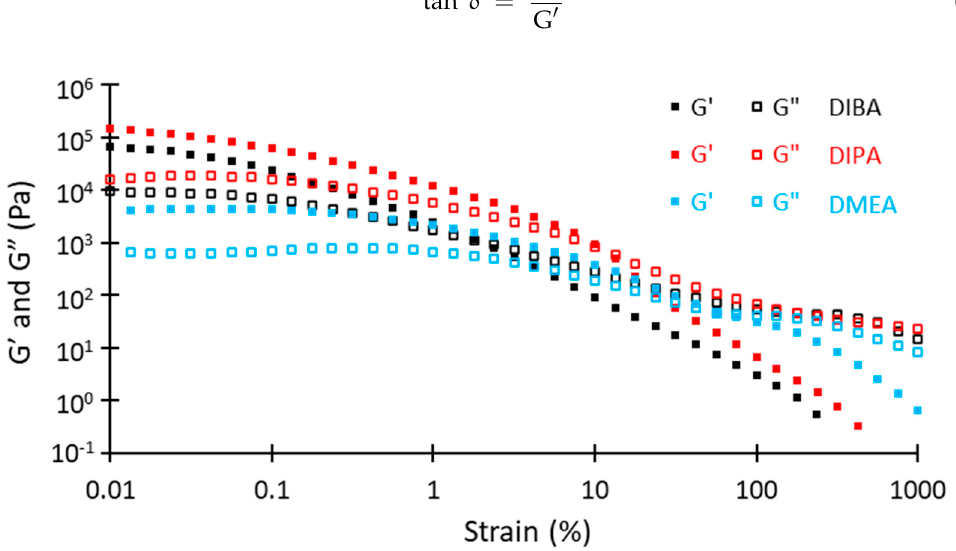
Figure 6. Log–log strain sweeps (1 Hz frequency) at 25 °C: 3 wt% DIBA-silicone oil gel ( black ); 3 wt% DIPA-silicone oil gel ( red ); and 3 wt% DMEA-silicone oil gel ( blue ). DIPA-silicone oil gel ( red ); and 3 wt% DMEA-silicone oil gel ( blue